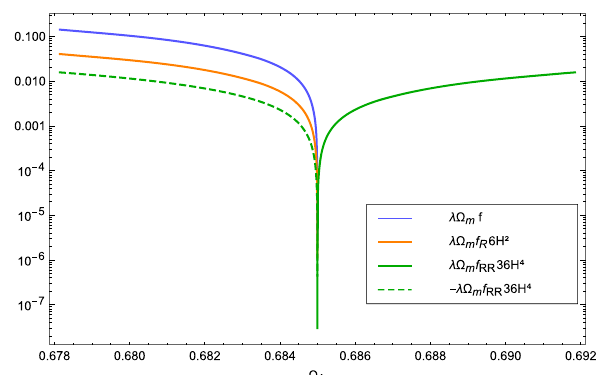
Fig. 2 Here the adimensional quantities given in Eqs. (69)–(71) are represented as a function of Ω